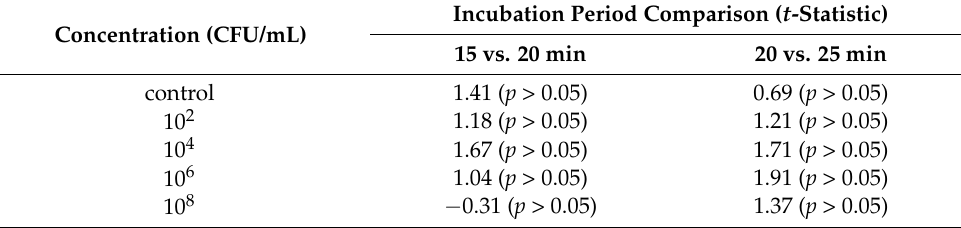
Table 1. Results summary of two-tailed two-sample t-tests assuming unequal variances between datasets of 15- and 20-min, and 20- and 25-min incubation periods. p -values of less than 0.05 were considered statistically significant.